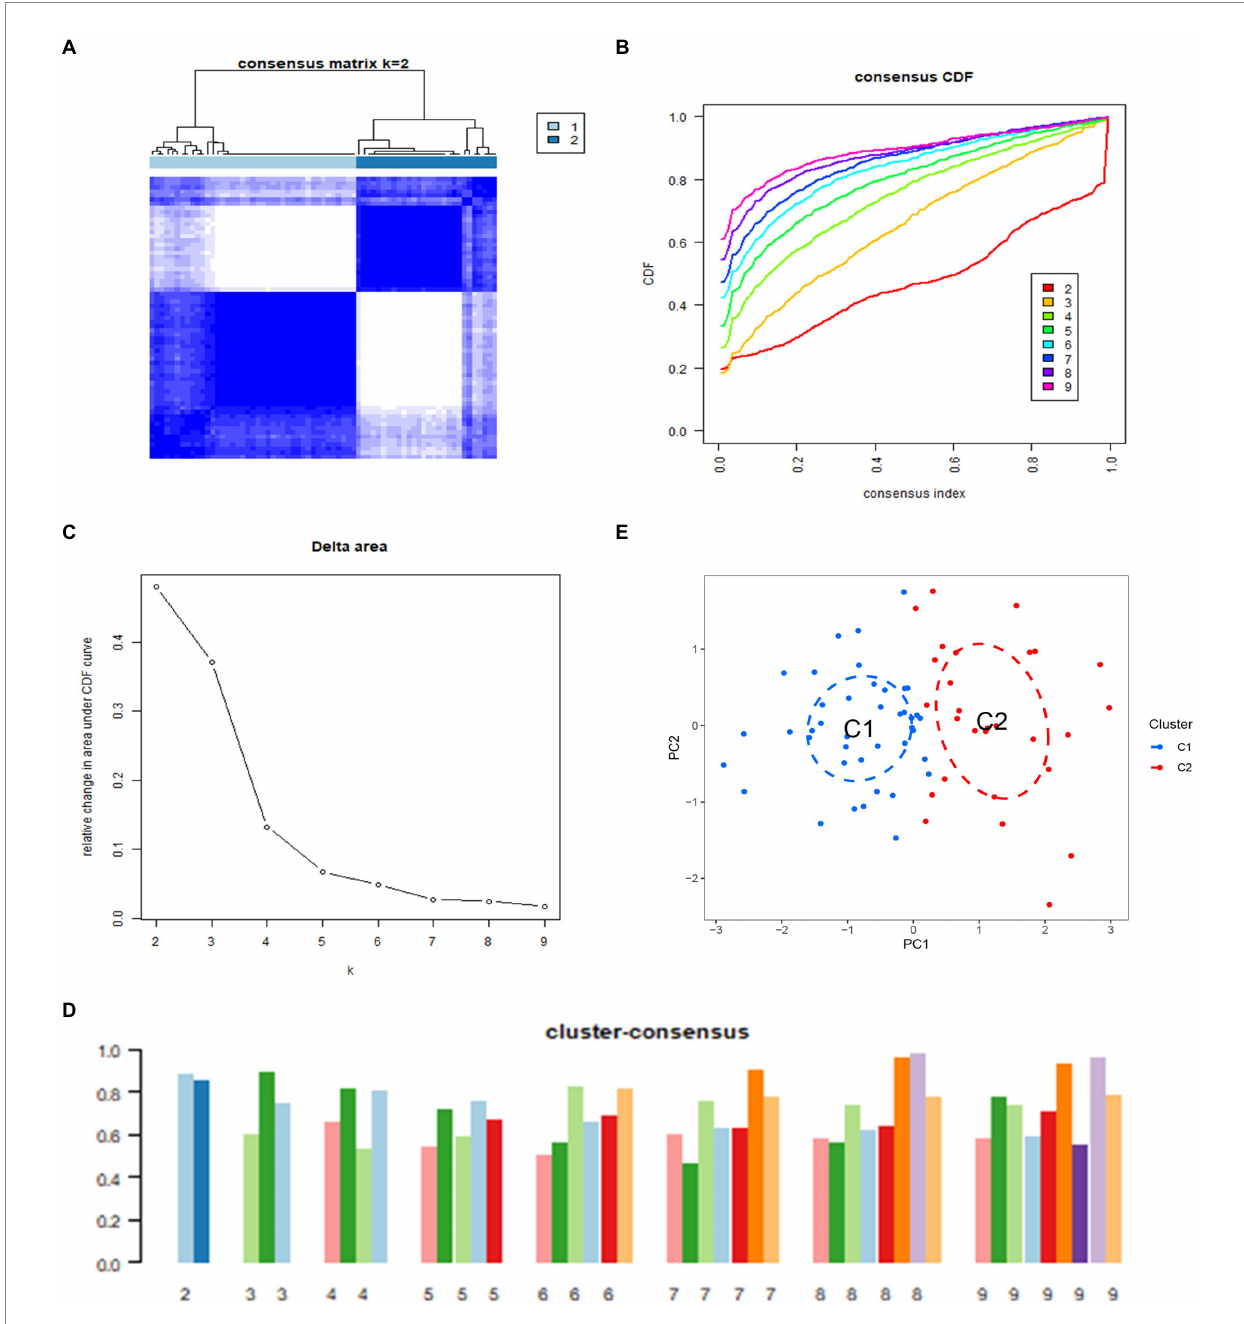
FIGURE 4 Identification of molecular clusters associated with anoikis in IS. (A) Consensus clustering matrix at k = 2. (B) Cumulative distribution function (CDF) curves representing k values of 2–9, respectively. (C) Representative CDF delta area curves. (D) Visualization of the distribution of the two clusters by principal component analysis (PCA). (E) Consensus clustering scores for k values of 2–9,